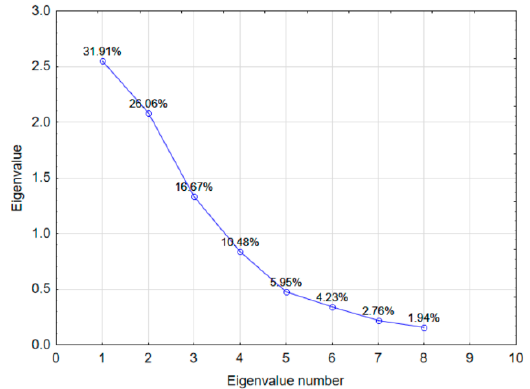
Figure 3. Scree plot for principal components.